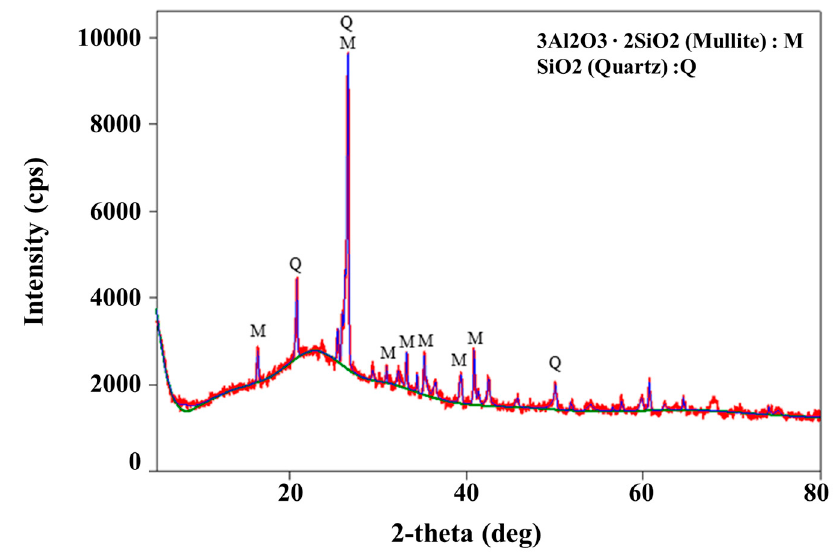
Figure 4. XRD results for fly ash.